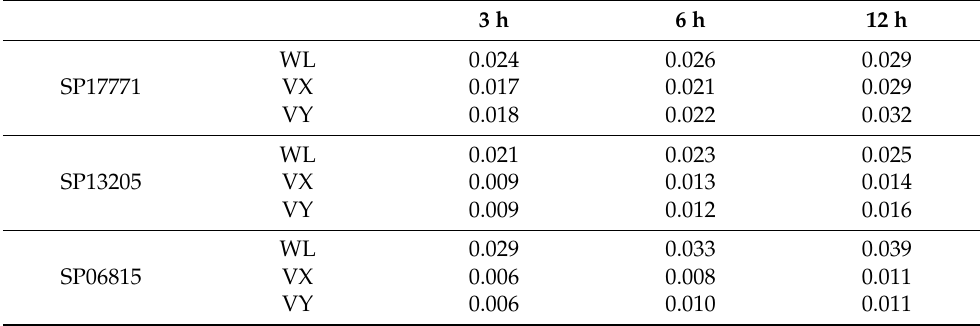
Table 5. Summary of root mean squared error (RMSE) between neural network forecast and ADCIRC simulation for water level (WL) in meters, velocity in the x direction (VX) in m/s, and velocity in the y direction (VY) in m/s for three save points using three forecast lead times (i.e., 3 h, 6 h, and 12 h) using 50 test